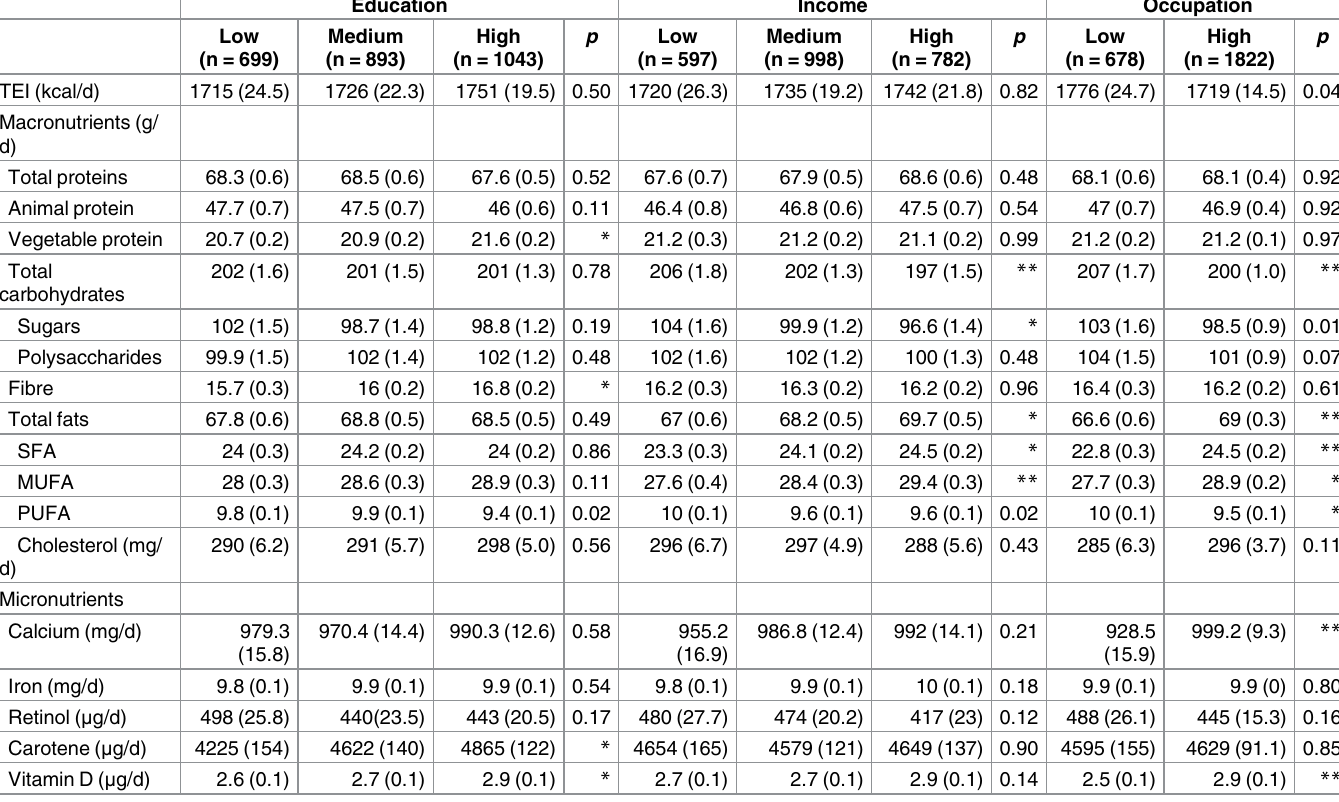
Table 3. Energy and nutrient intake (mean & SE) among women from “Bus Sante´” study, Geneva, Switzerland, years2005–2012,by socioeco- nomic status indicator, adjusted for age and energy.